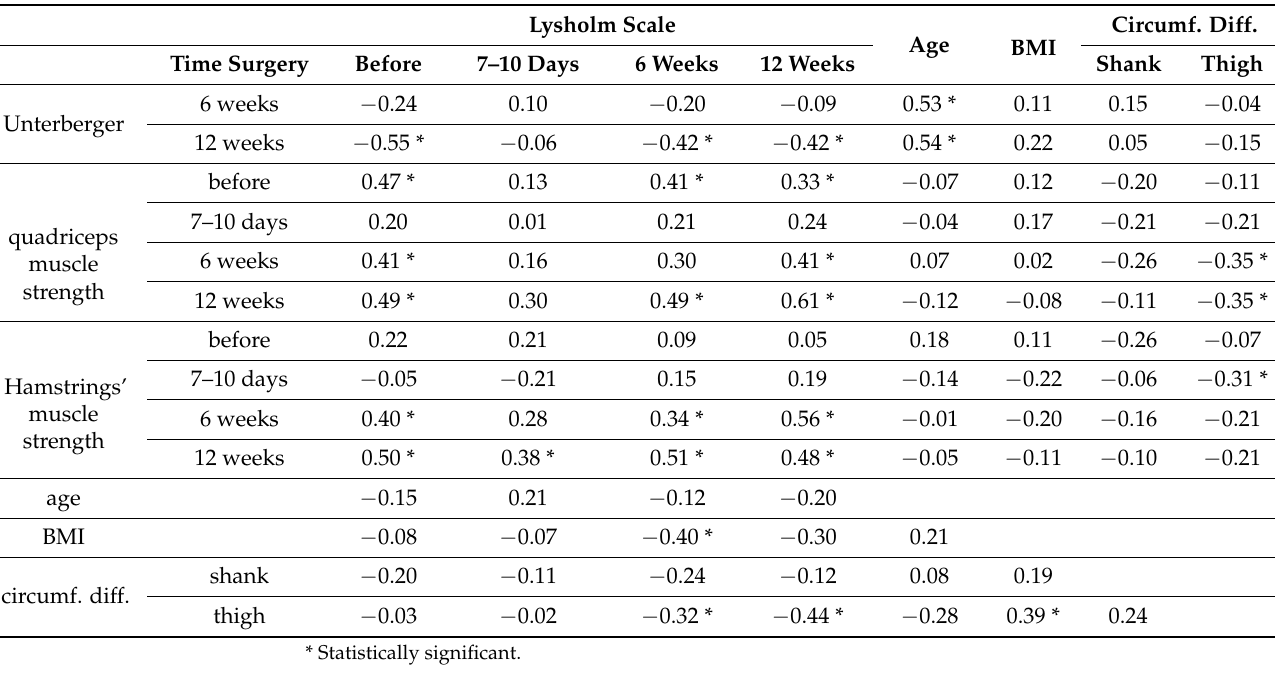
Circumf. Diff. Age BMI